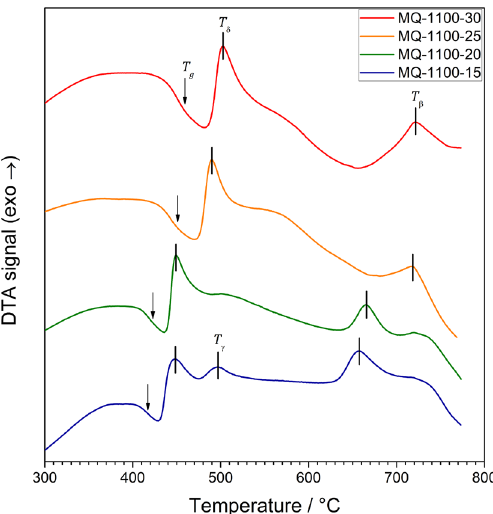
Figure 1. DTA traces of glassy samples synthesized under different conditions (melting time from 15 to 30 ◦ min at 1100 C). Glass transition and crystallization thermal events are marked. The phases were ascribed to crystallization processes according to XRD